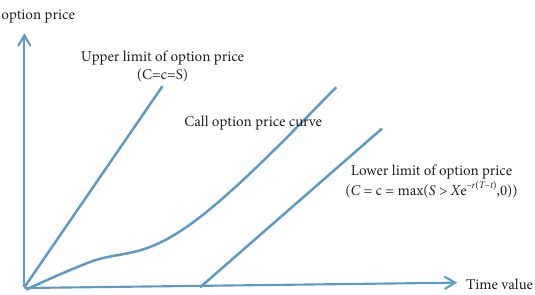
Figure 1: European call option price curve of no income